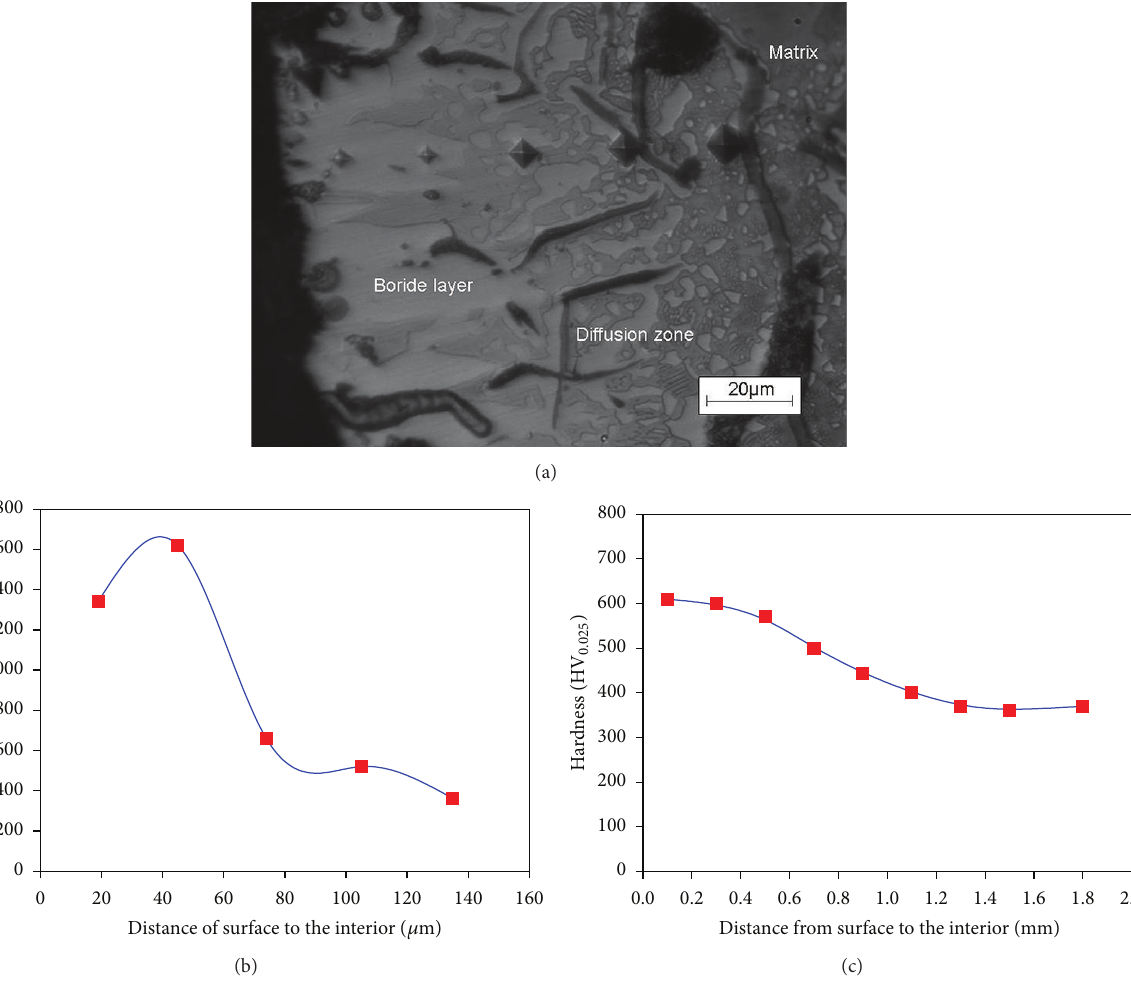
Figure 2: (a) Optical micrographs of the boronized at GCI 1223K for 6 h, showing the hardness indentation variation with distance from surface to interior; (b) hardness values of the boronized GCI at 1223K for 6h; (c) hardness values of the quenched and tempered GCI.